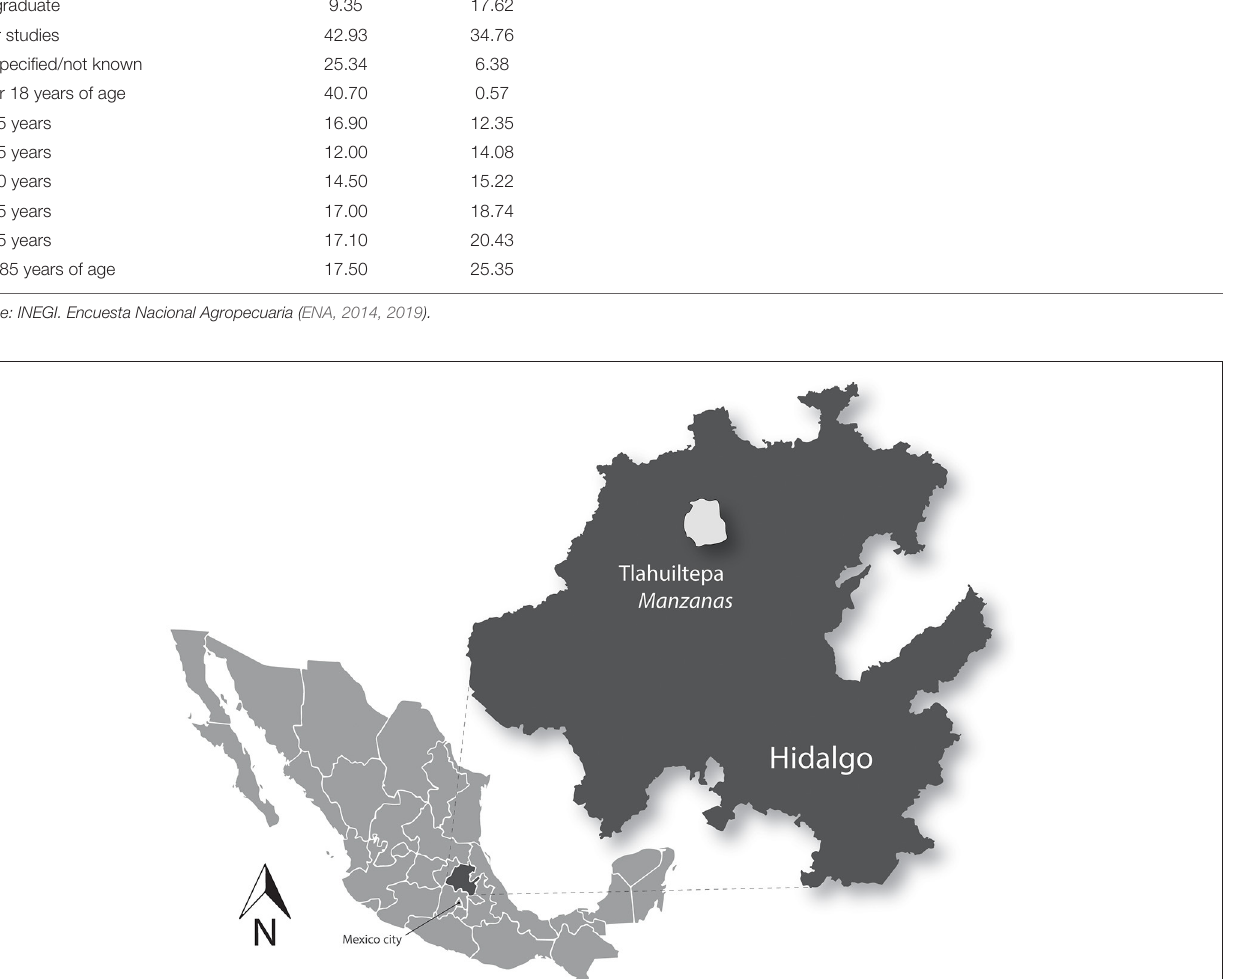
processes. Promoting sales outside the community bolstered the relationship with the cooperative. At the same time, attendance in religious and communitarian celebrations and